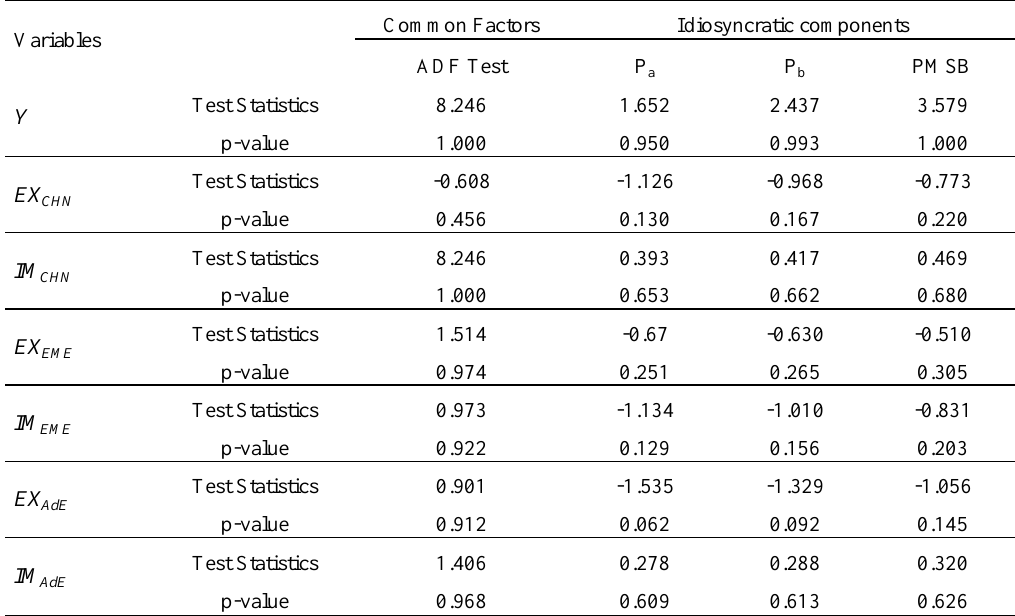
Table 3 : Reese and Westerlund (2016) unit root tests